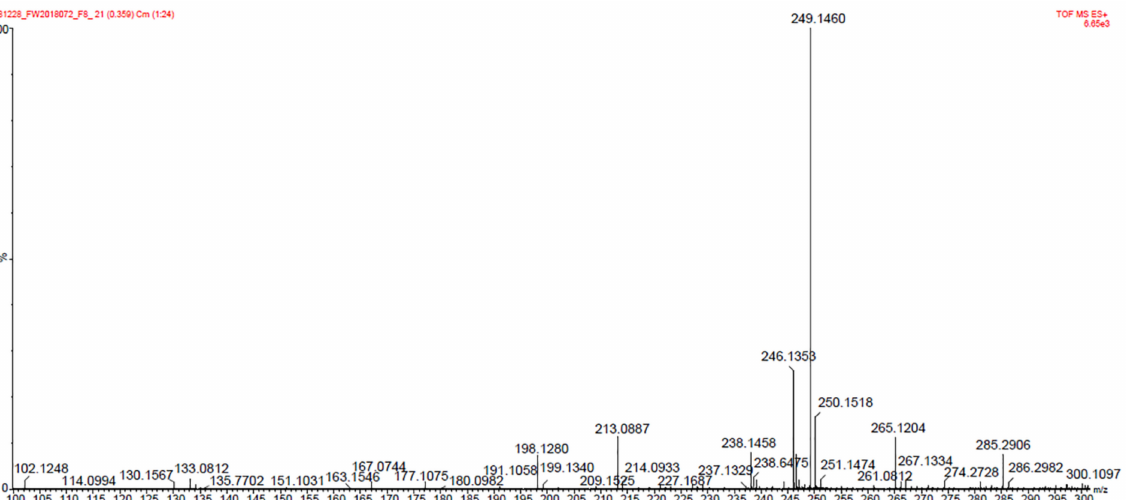
Figure 3. HRESIMS spectra of compound 4